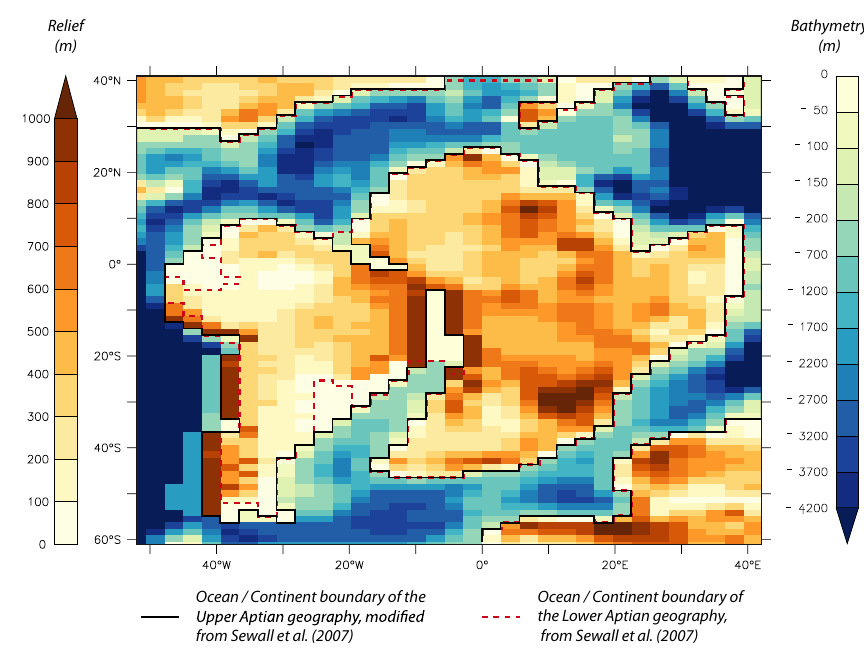
Figure 2 Fig. 2. Topography and bathymetry used in the GCM Model, from Sewall et al.